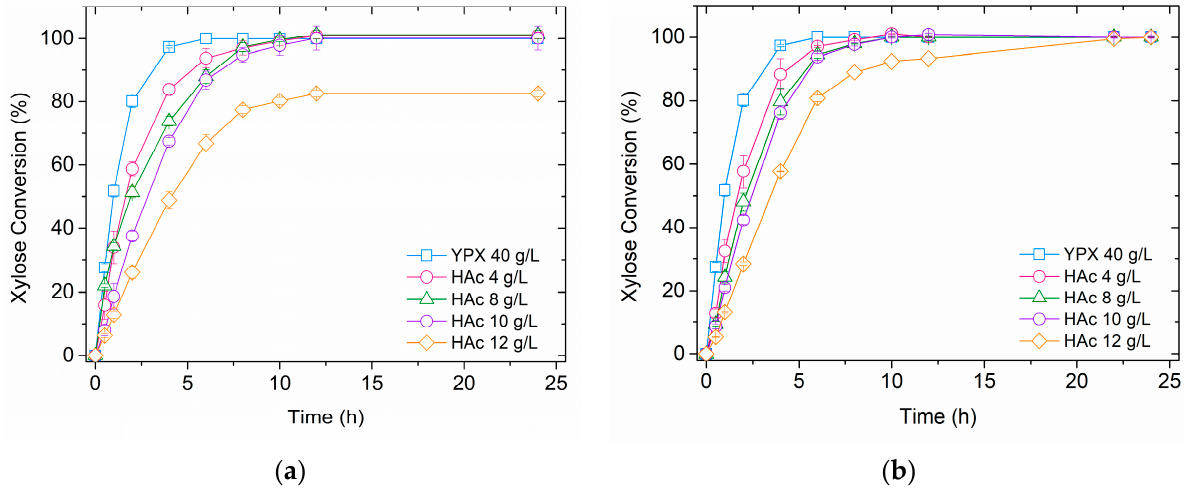
Figure 1. Fermentation performance of immobilized T18 in YPX (40 g/L) in different acetic acid (Hac) concentrations. ( a ) Ca-alginate beads and ( b ) Ca-alginate/chitosan beads. Experiments performed with 1:1 V beads /V medium , 35 °C, 150 rpm, and pH 5.2. Table 1. Performance indexes of YPX (40 g/L) fermentations in the presence of different acetic acid concentrations (0–12.0 g/L) by T18 yeast immobilized on Ca-alginate and Ca-alginate/chitosan beads (1:1 V beads /V medium , 35 °C, 150 rpm, and pH 5.2). (a–i) Matching letters indicate that the means did not differ significantly, according to the Tukey test at 95% confidence level.